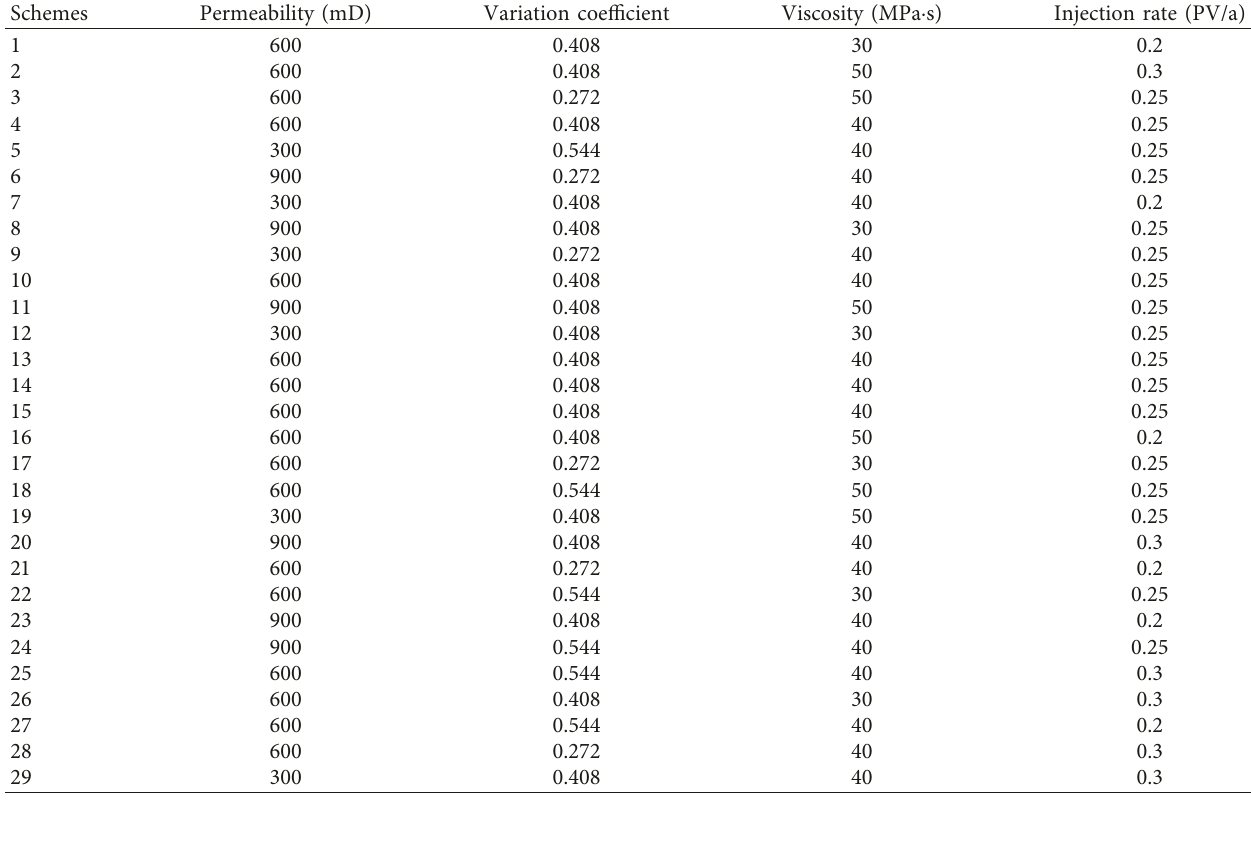
Table 5: Final schemes used in RSM.